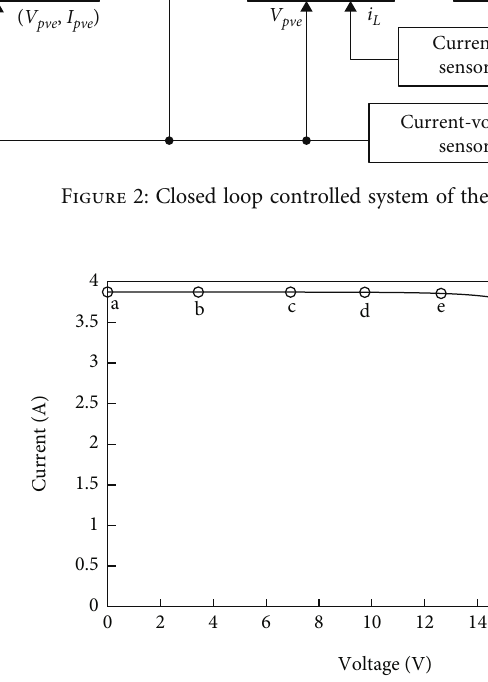
Figure 3: 12-segment-based linearization of the PV I - V